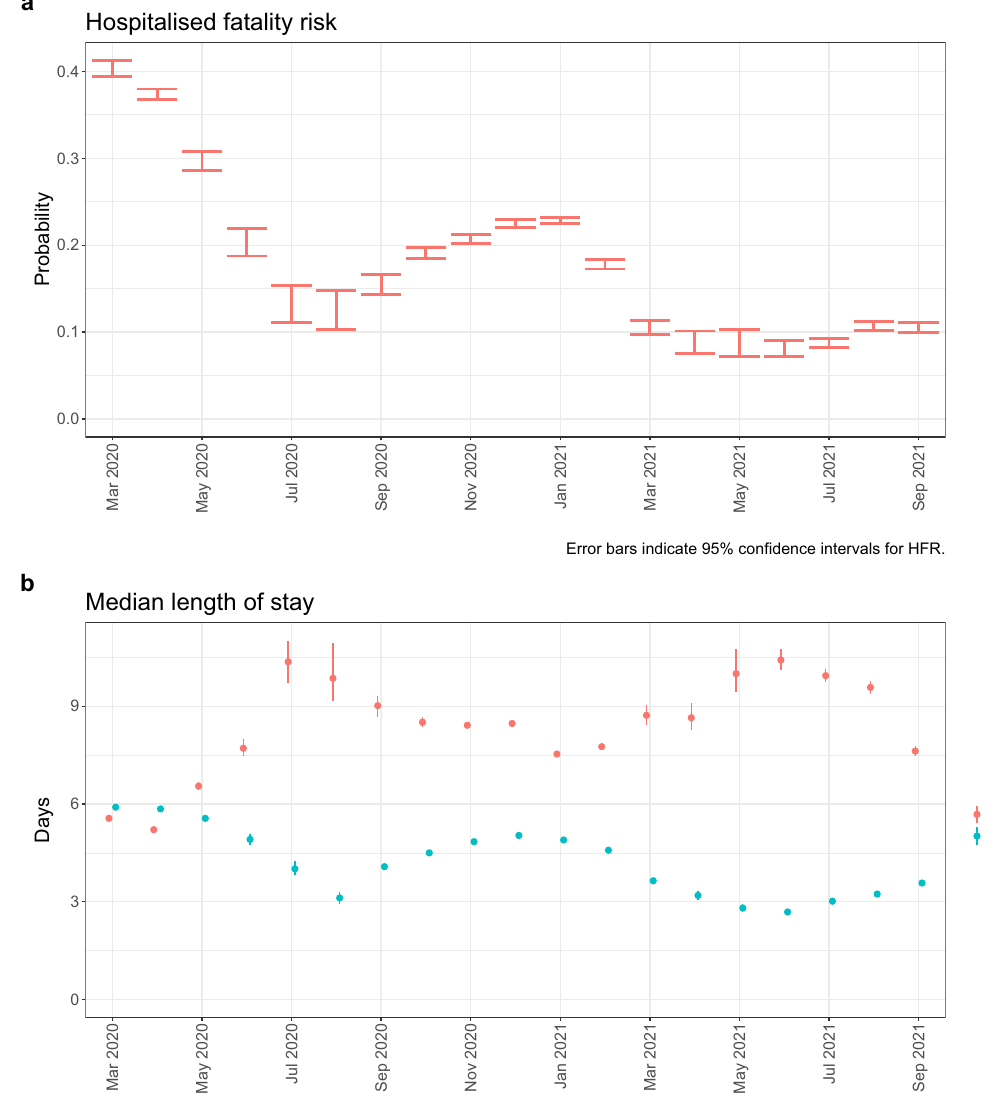
Line ranges indicate 95% confidence intervals around median. 2021. Unadjusted for other covariates. n =259,727 individuals. Error bars are 95% con fi dence